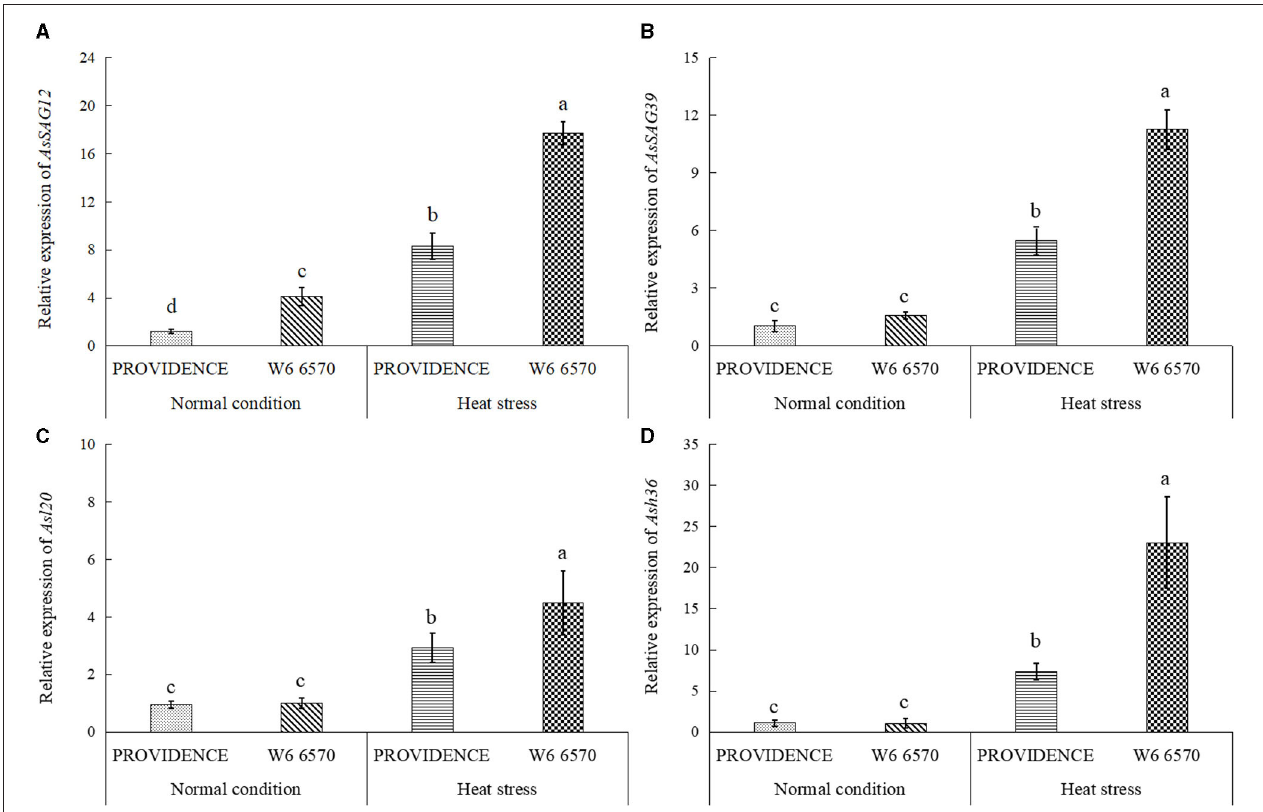
FIGURE 7 | Changes in transcript levels of (A) AsSAG12 , (B) AsSAG39 , (C) Asl20 , and (D) Ash36 in the leaves of two creeping bentgrass materials (PROVIDENCE and W6 6570) in response to 15 days of heat stress (38/33 ◦ C, day/night) in controlled growth chambers. Vertical bars indicate ± SE of mean ( n = 4), and different letters above column indicate significant differences ( P ≤